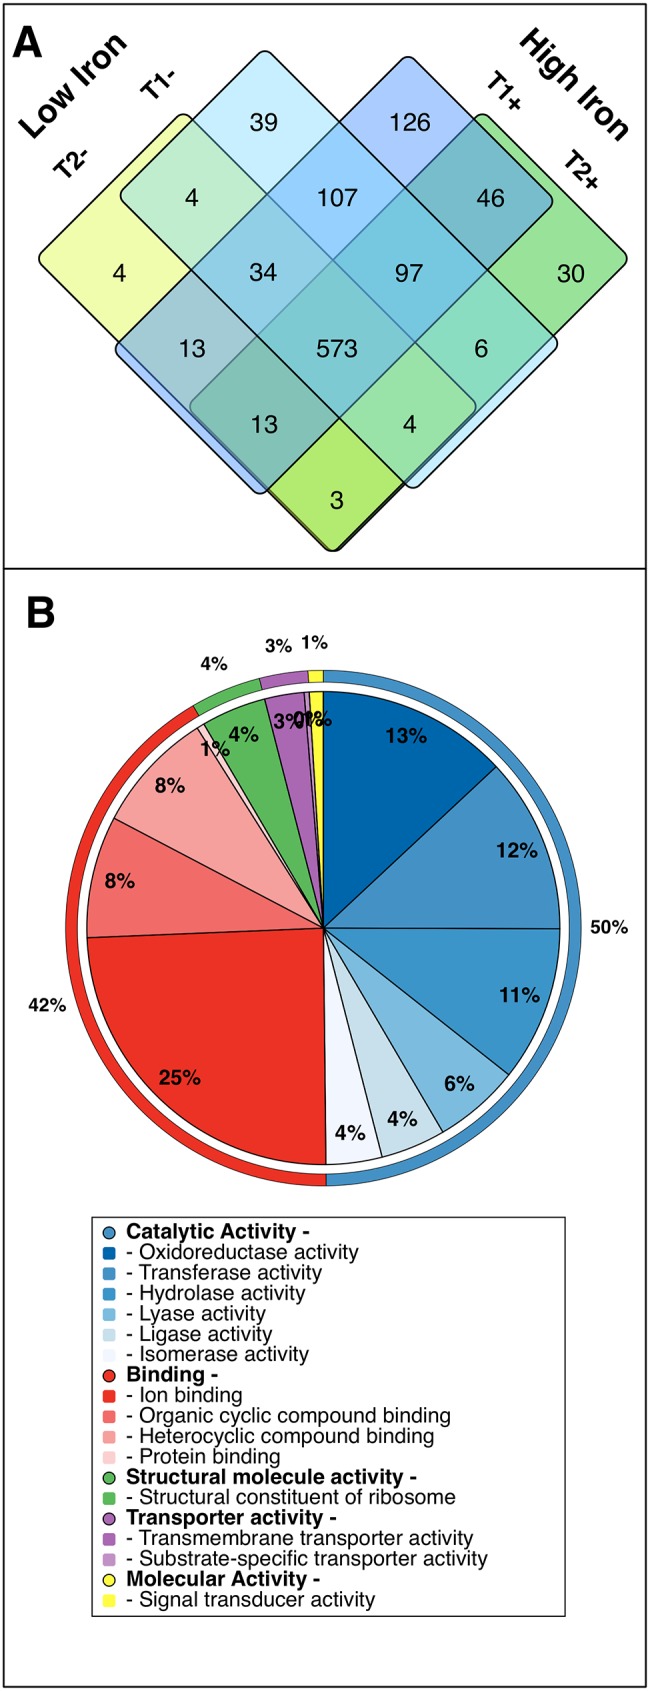
Summary of acquired proteomic data.A) Venn diagram depicting all observed proteins and their distribution amongst our 4 sample treatments (T1+, T1-, T2+ and T2-). B) Pie chart depicting gene ontology terms for all observed proteins as annotated using Blast2GO; external and internal charts show level 2 and 3 cellular component terms, respectively.